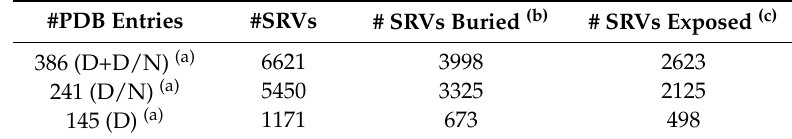
Table 1. Summary statistics of the HVAR3D